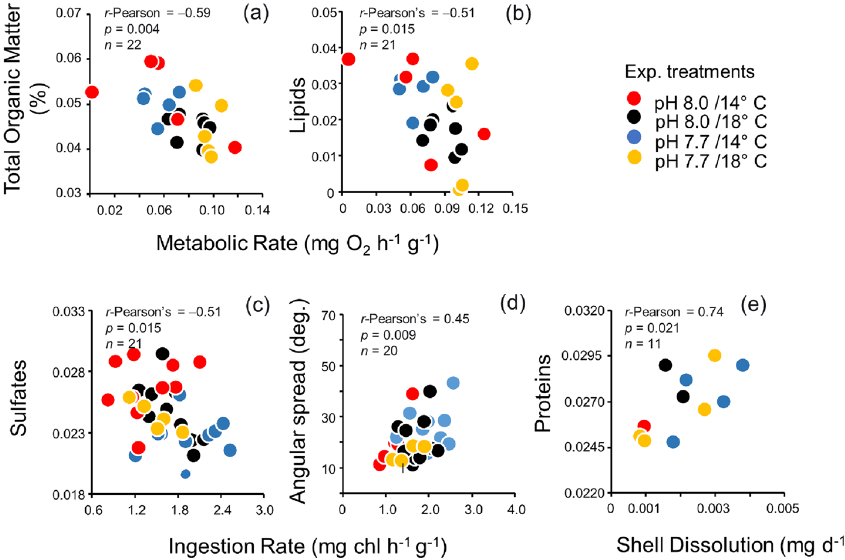
Figure 6. Significant correlations ( r -Pearson) between ( a ) total organic matter in the carbonate matrix of Argopecten purpuratus ; ( b , c , e ) organic compounds, and ( d ) calcite crystal angular spread recorded in the shell periostracum with metabolic( a , b ), ingestion ( c , d ) and dissolution rates ( e ) (see also Table S1 supplementary material). Dots of different color indicate different combinations of pH/temperature